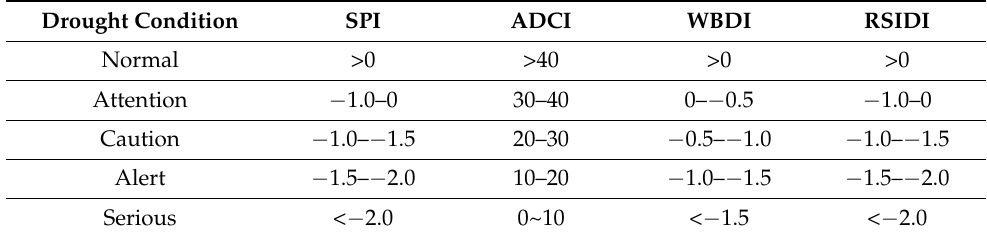
Table 2. Range of the drought indices used in this study. Drought Condition SPI